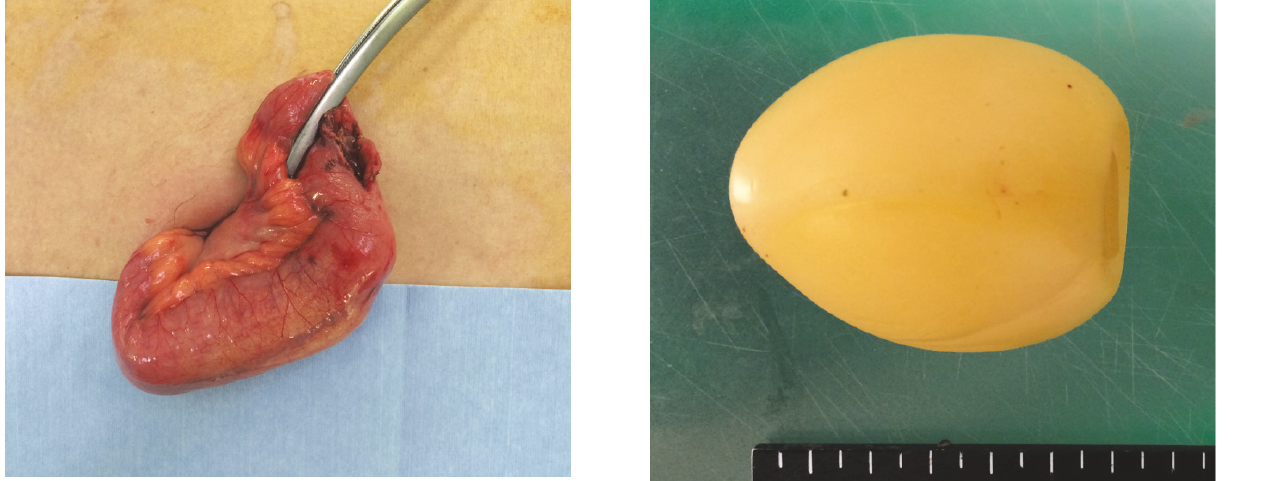
Figure 5: The foreign body was a sex toy made with soft rubber.The original size was 5.5 ×